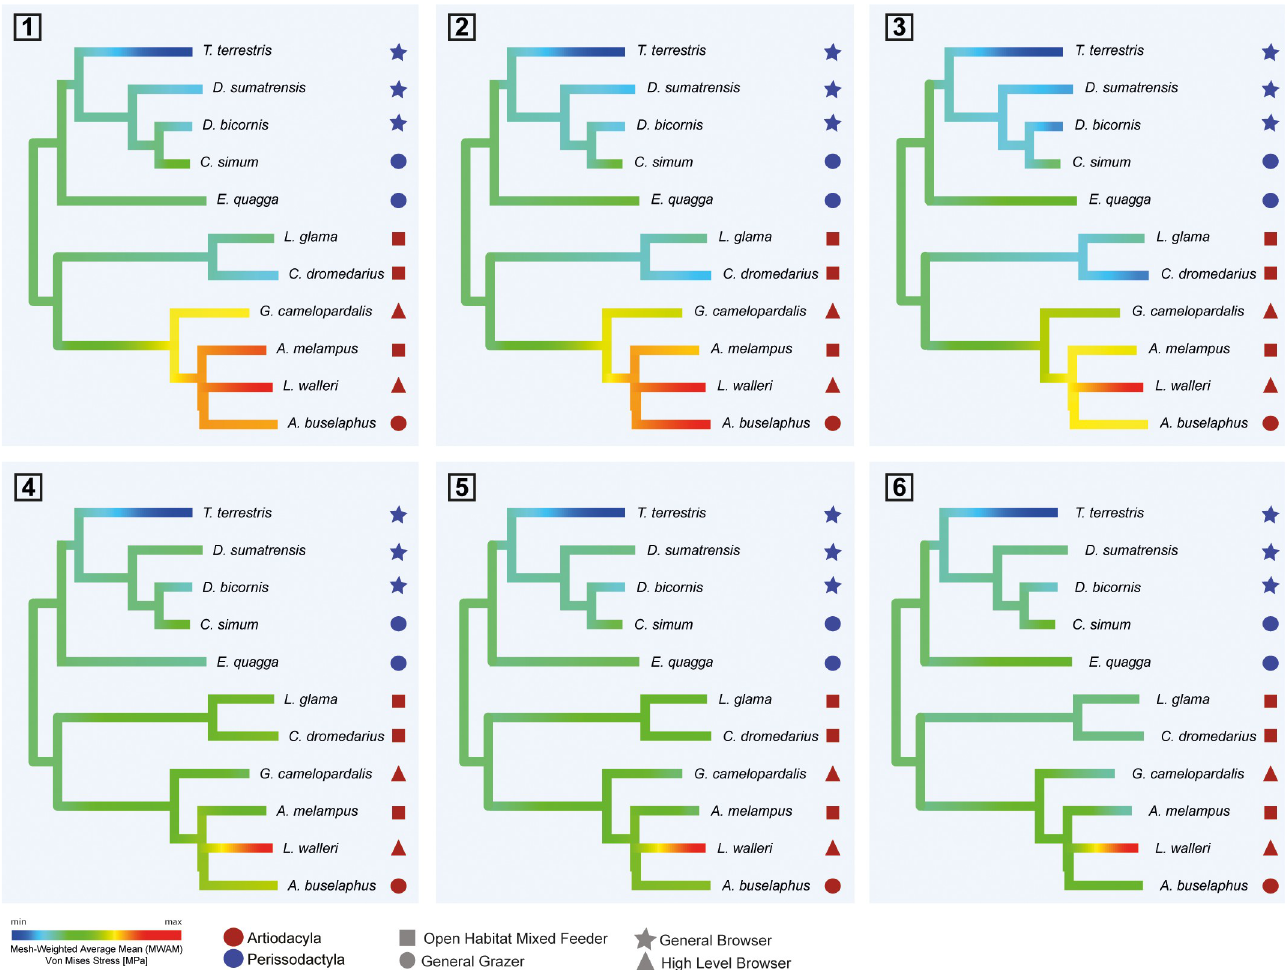
Fig 7. Stress values MWAM on the phylogeny for the six biting cases: Lateral cases 1) in M1 2) in M2 and 3) in M3. Orthal cases 4) in M1 5) in M2 and 6) in M3. The colour ranges from red representing higher average stress values, to blue, representing lower stress values.